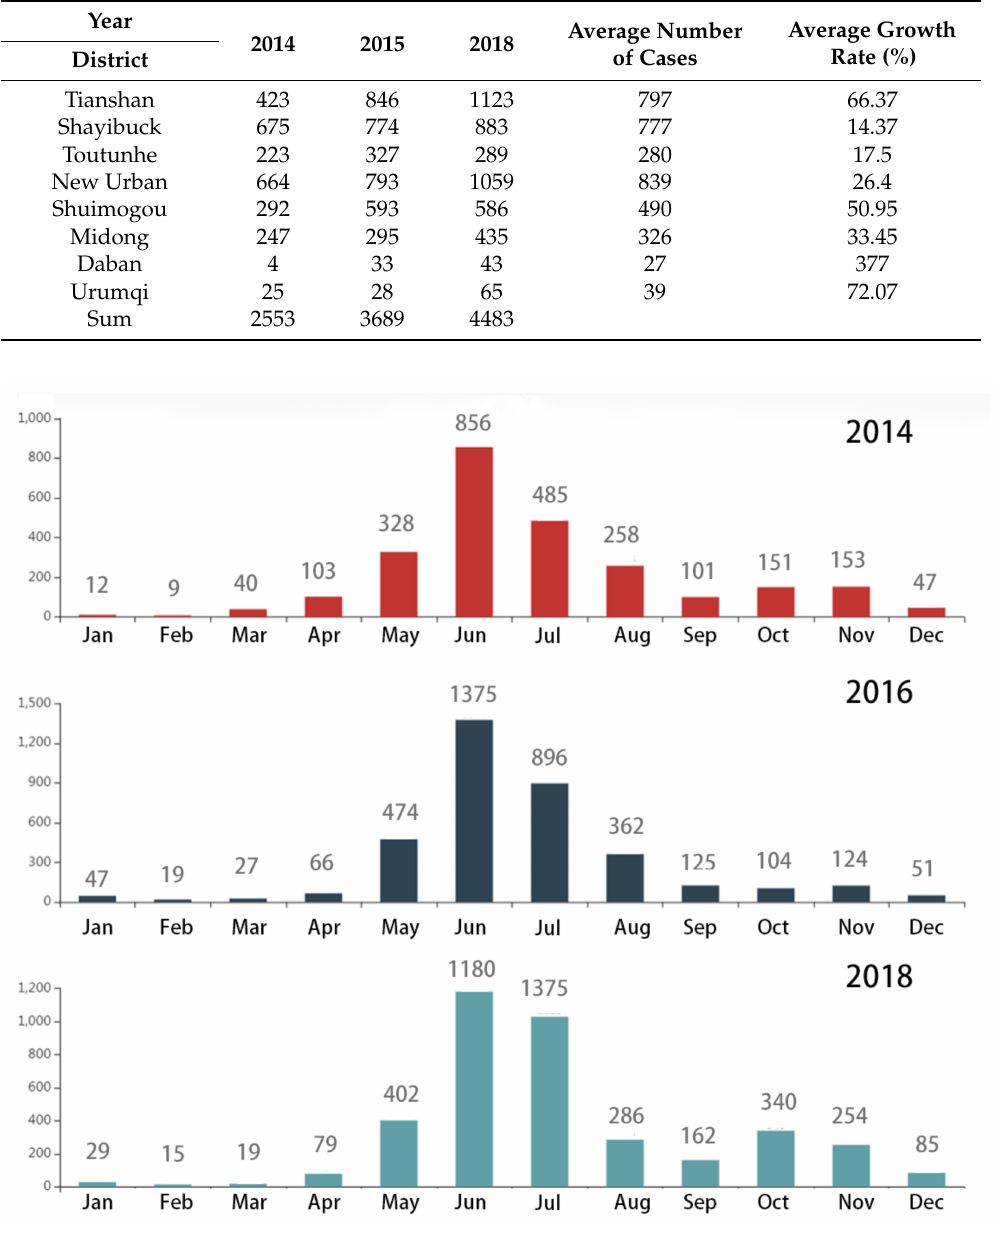
Figure 5. Month scale distribution of HFMD cases in Urumqi from 2014 to